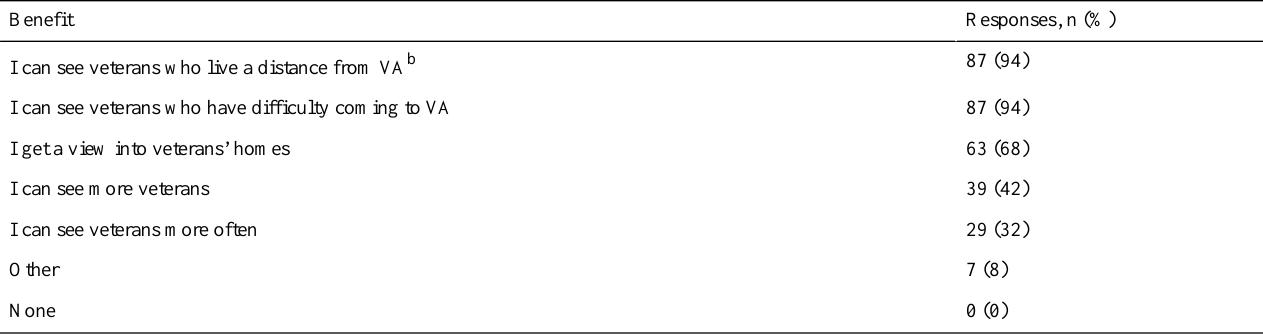
Table 3. Response to the question “As a practitioner, what benefits do you experience from using video telehealth with Veterans?” a